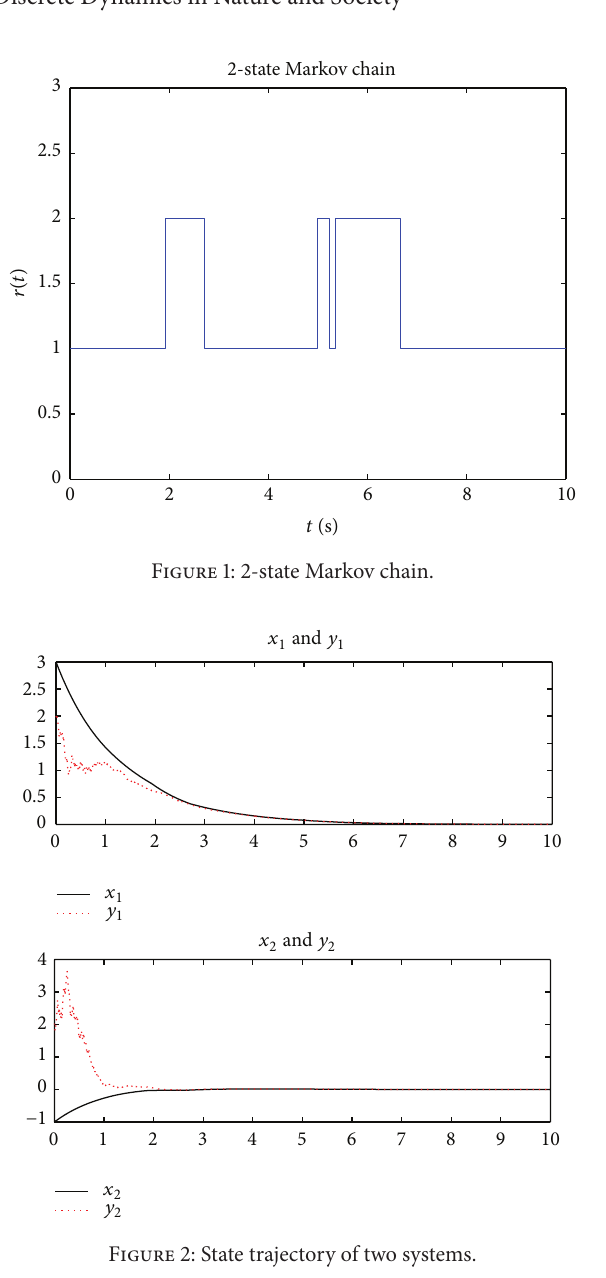
Figure 2: State trajectory of two systems.